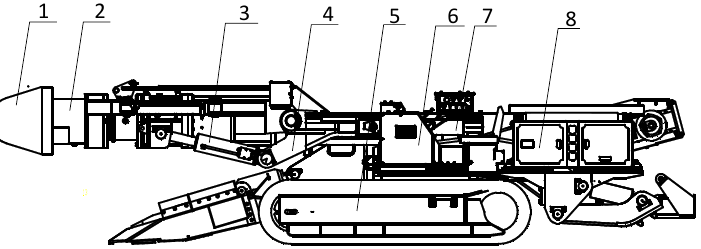
Figure 1. Structure diagram of roadheader. 1. Cutting head 2. Cutting arm 3. Lifting cylinders 4. Revolving platform 5. Travelling mechanism 6. Rack 7. Angling cylinders 8. Electrical system.